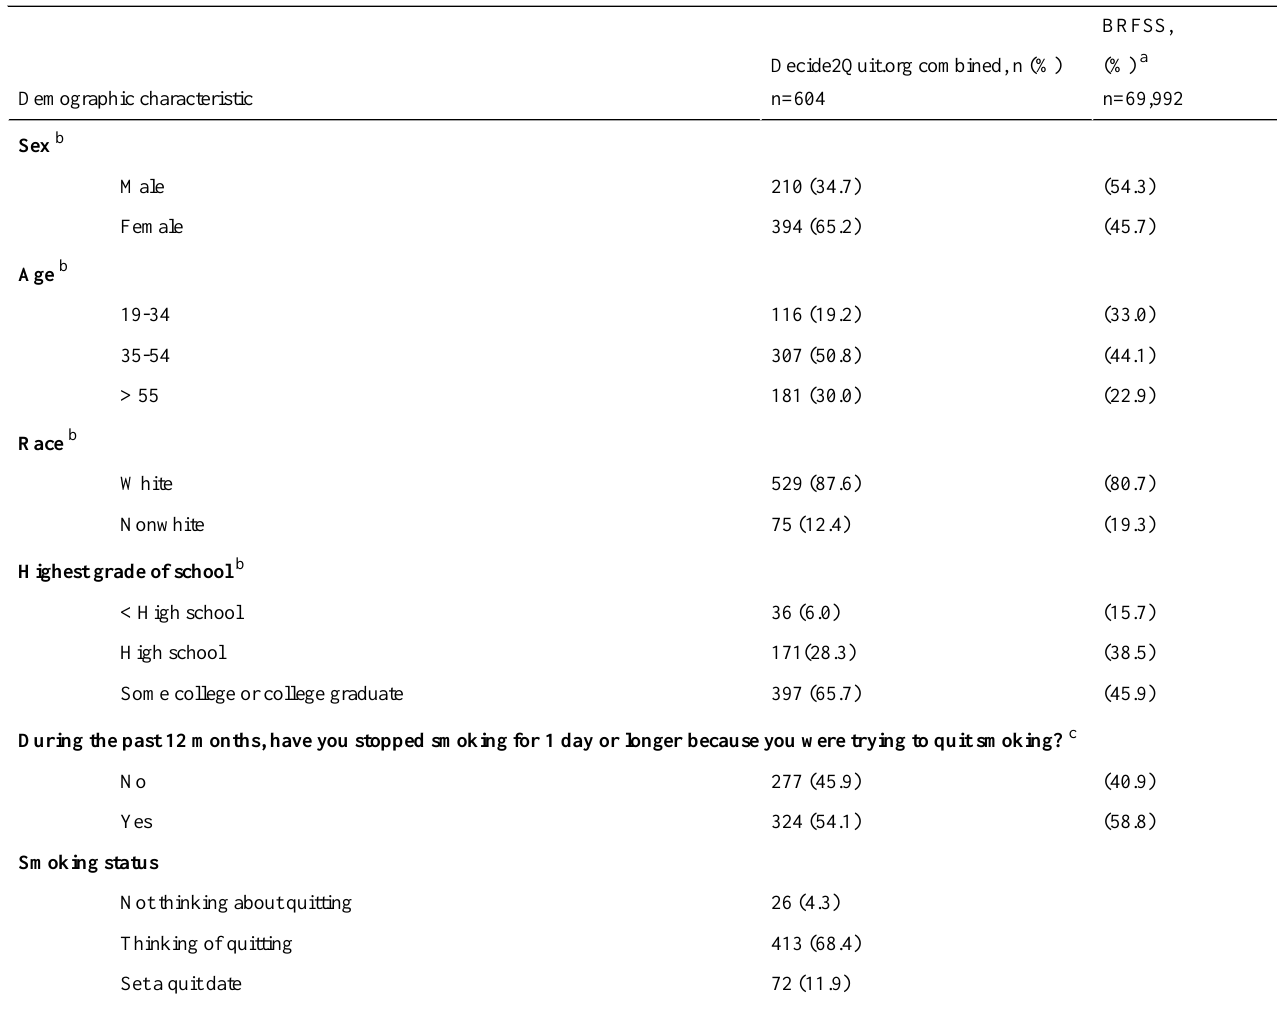
Table 1. Characteristics of smokers participating in the Behavioral Risk Factor Surveillance Survey (BRFSS) and all smokers (Google, medical-referred, and dental-referred combined) who engaged in the Web-assisted tobacco intervention